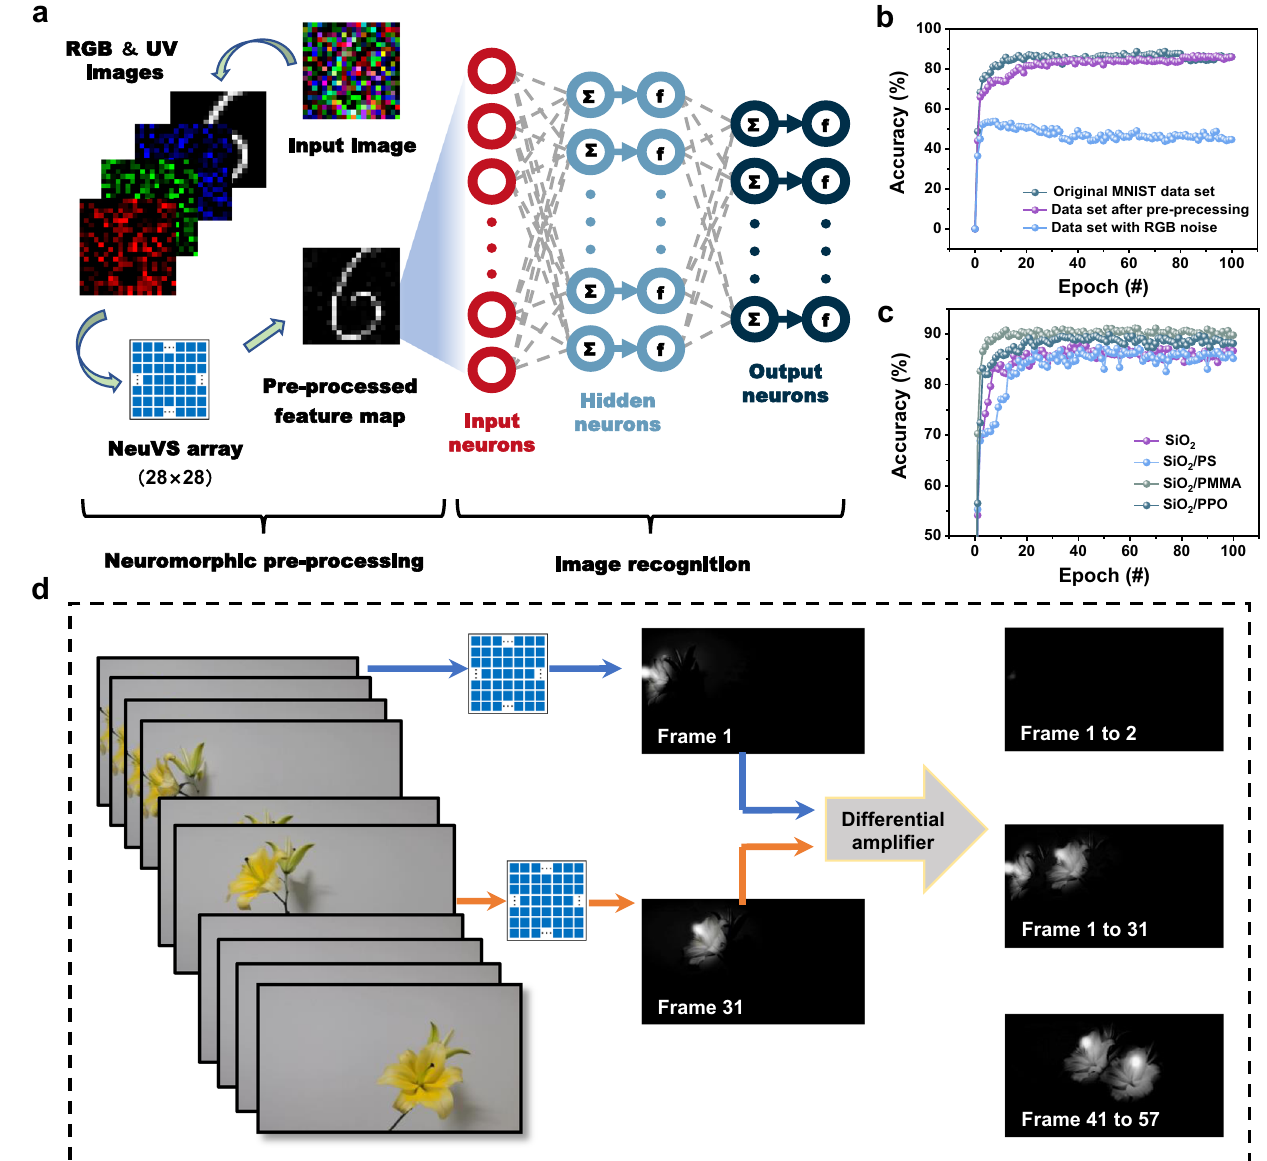
Fig. 5 | Image recognition using the neuromorphic vision organic sensor. a Schematicillustrationofthepre-processingfeaturerealizationandthemultilayer neural network for digit recognition. b Recognition accuracy with and